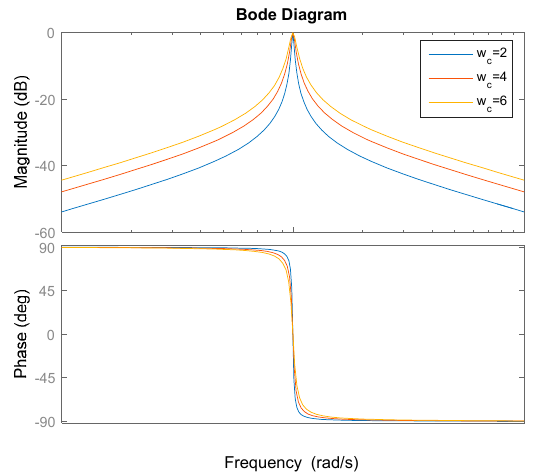
Figure 8. Bode diagram for different values of w c when K R is constant.